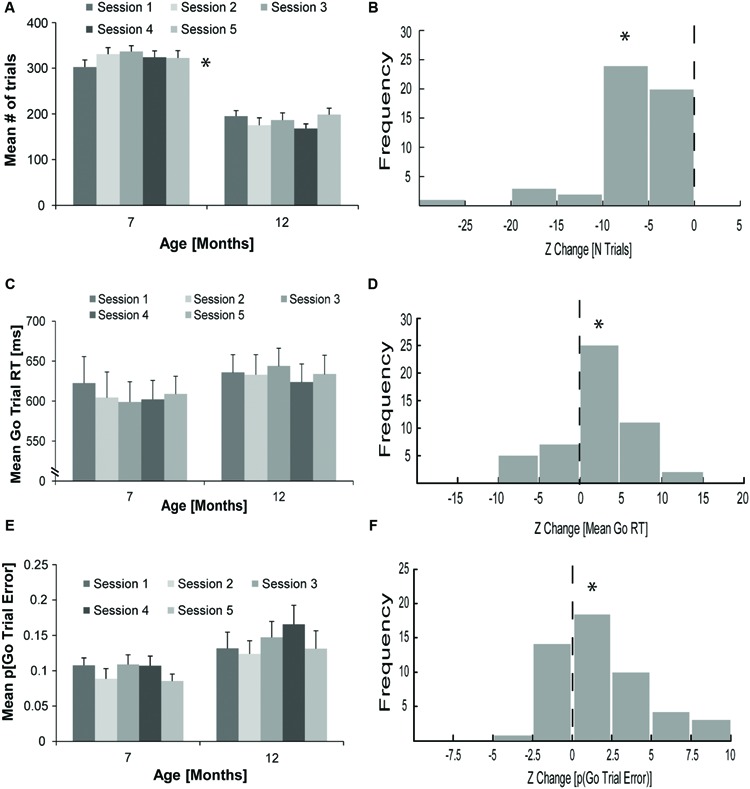
Changes in countermanding task performance of rats with aging. (A) Mean ± standard error of the mean (SEM) total number of trials performed in five individual, 1-h countermanding task sessions (light–dark gray bars) for rats (N = 10) at 7 and 12 months of age (∗significant main effect of age with analysis of variance [ANOVA]). (B) Frequency distribution (n = 50) for Z change in the total number of trials performed for rats (N = 10) comparing the total number of trials performed in five individual sessions at 12 months of age to their overall mean total number of trials performed over five sessions at 7 months of age (∗significant difference from zero, one-sample t-test). (C) Mean (± SEM) go trial RT in five individual countermanding task sessions (light–dark gray bars) for rats (N = 10) at 7 and 12 months of age. (D) Frequency distribution (n = 50) for the Z change in mean go trial RT for rats (N = 10) comparing mean go trial RT in five individual sessions at 12 months of age to their overall mean go trial RT over five sessions at 7 months of age (∗significant difference from zero, one-sample t-test). (E) Mean (± SEM) proportion of go trial errors (p[go trial error]) in five individual countermanding task sessions (light–dark gray bars) for rats (N = 10) at 7 and 12 months of age. (F) Frequency distribution (n = 50) for the Z change in the p(go trial error) for rats (N = 10) comparing the p(go trial error) in five individual sessions at 12 months of age to their overall p(go trial error) over five sessions at 7 months of age (∗significant difference from zero, one-sample t-test).